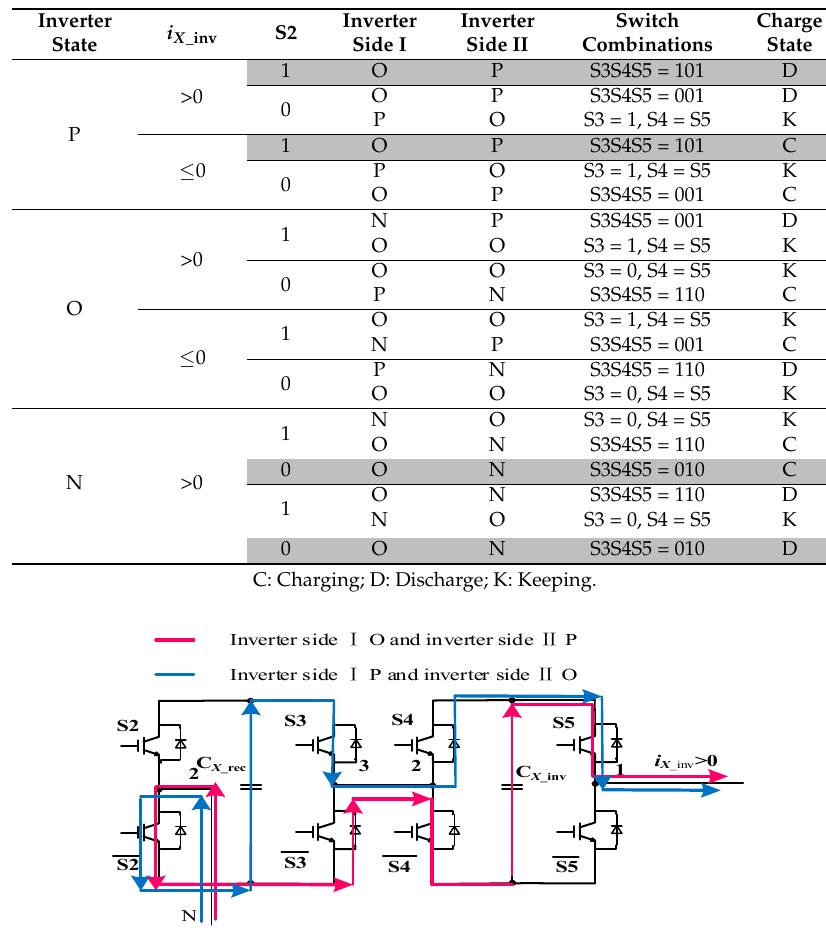
Figure 6. Voltage balancing algorithm of C X _rec . Table 4. Switching states of rectifier side and inverter side.